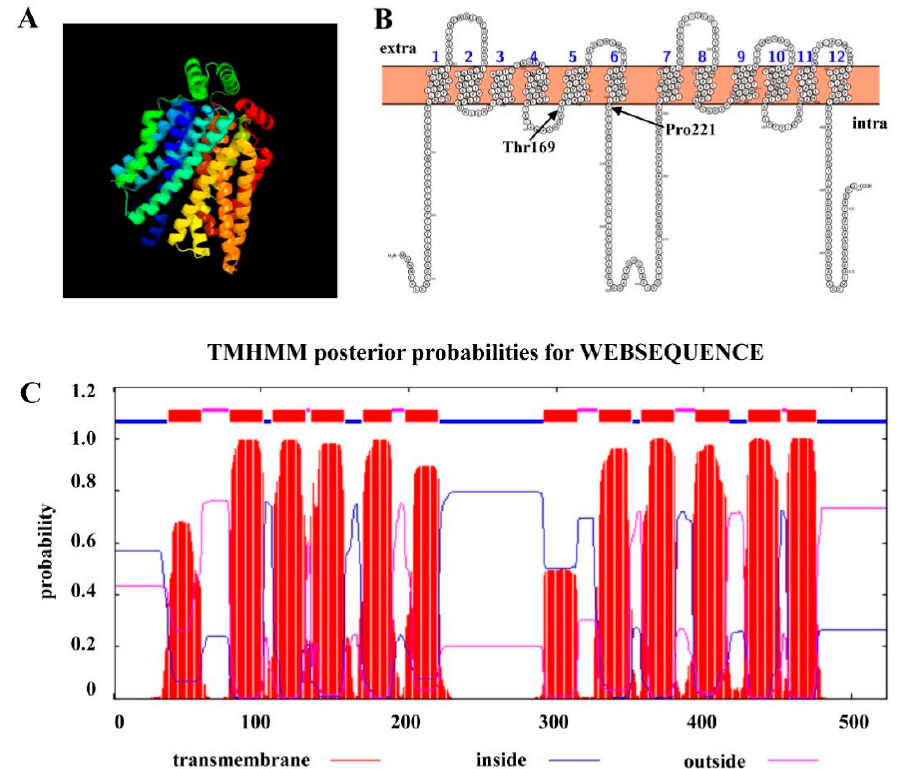
Figure 5. ChHxt6 gene coding a hexose transporter protein. ( A ) 3D-model of ChHxt6 predicted by SWISS-MODEL. ( B ) Amino acid sequence and putative topology of ChHxt6p are shown in the membrane. ( C ) TMHMM posterior possibilities of amino acid in ChHxt6 by WEBSEQUENCE. The red lines represent the transmembrane part, the blue lines represent the intracellular part, and the purple lines represent the extracellular part.